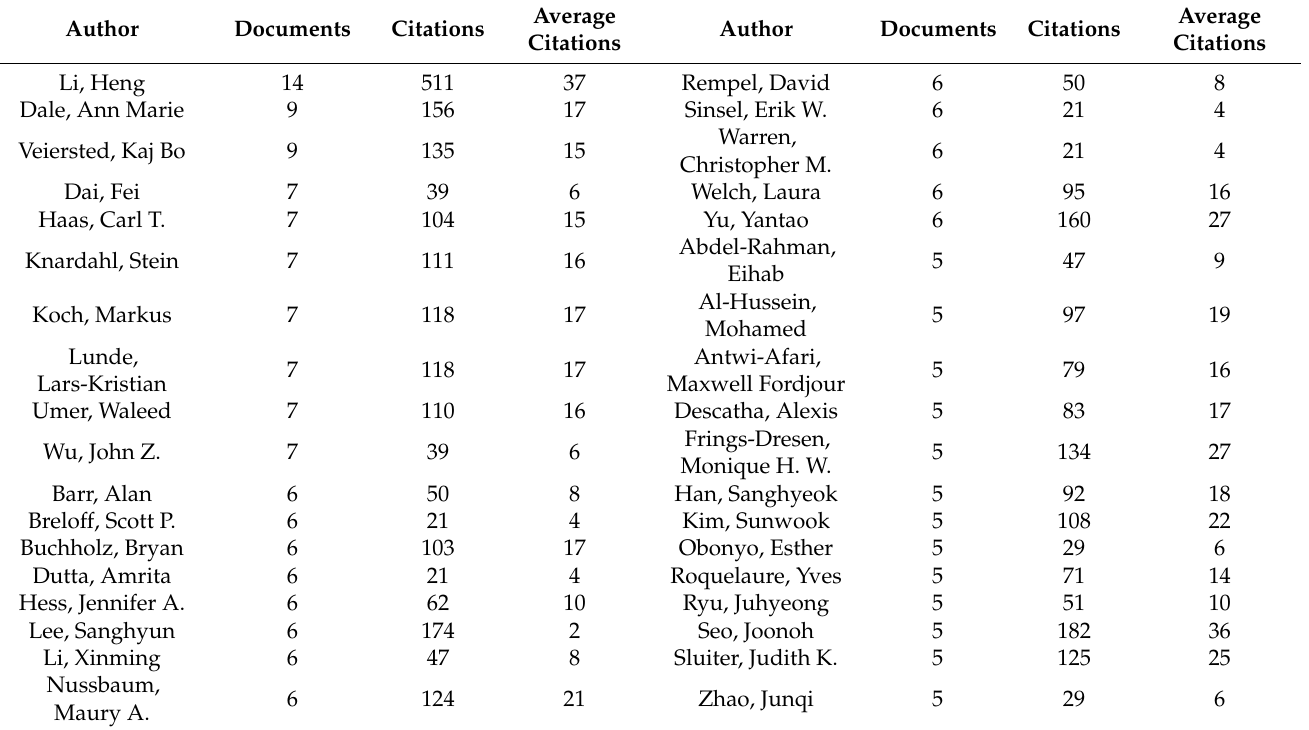
Table 2. Co-authorship analysis (descending order according to